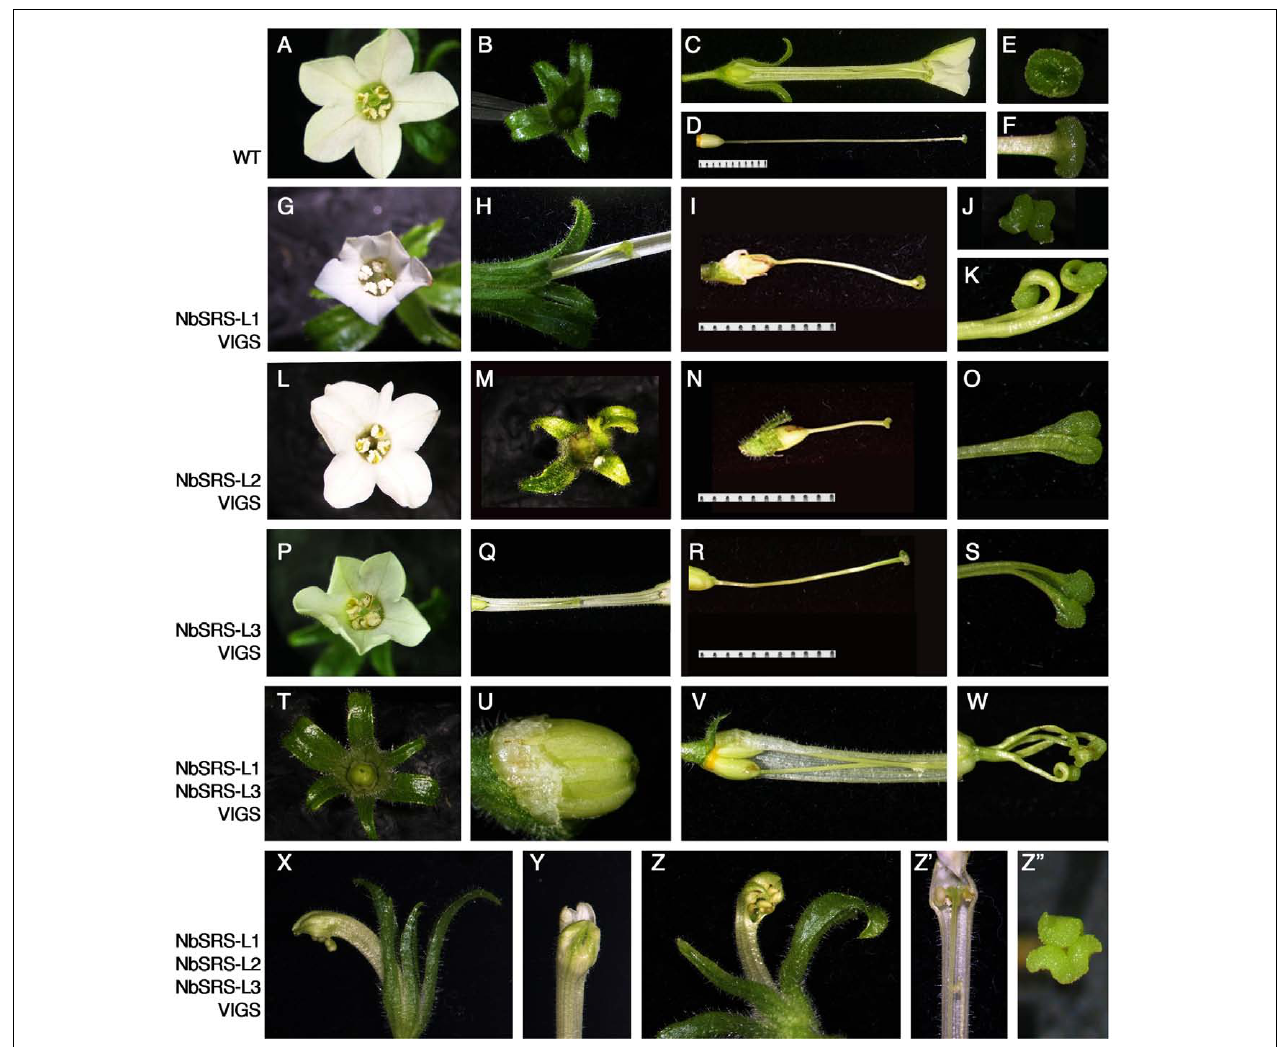
FIGURE 5 | Phenotypes of N. benthamiana plants inoculated with different pTRV2-NbSRS-L constructs. (A–F) Wild type N. benthamiana flower at anthesis. (A) Top view. Five expanded white petals and the central stigma surrounded by five stamens are clearly seen. (B) Top view of the dissected calix, formed by five green narrow sepals. (C) Lateral view of the flower, where some petals al sepals have been removed to show the ovary and the long style, that ends in a stigma leveled with the anthers. (D) Lateral view of the gynoecium. (E,F) Top and lateral view of the stigma. (G) NbSRS-L1-VIGS flower. The petals are reduced in size and the stigma is not visible at the center. (H) Lateral view of the basal part of the flowers, where some petals have been removed, to expose the short style. (I) NbSRS-L1-VIGS gynoecium. (J,K) Two examples of the defects found in the stigmas of NbSRS-L1-VIGS pistils. (L) NbSRS-L2-VIGS flower. The corolla is not symmetrical because one petal is severely underdeveloped. The stigma is not visible. (M) Top view of the dissected calix of a NBSRS-L2-VIGS flower. One of the sepals is reduced in size and deformed. (N) NbSRS-L2-VIGS gynoecium. (O) Close-up of the stigma shown in (N) , where the abnormal shape is visible. (P) Top view of a NbSRS-L3-VIGS flower. Note the unexpanded greenish corolla. (Q) Lateral view of a NbSRS-L3-VIGS flower where some petals have been removed to expose the short style. (R) Lateral view of a NbSRS-L3-VIGS gynoecium. (S) Example of defects observed in NbSRS-L3-VIGS styles. (T–W) Indeterminate phenotypes of flowers treated with TRV2-NbSRS-L1 and TRV2-NbSRS-L3 constructs simultaneously. (T) 6-sepal calix. (U) 4-carpel ovary. (V) Bi-pistillate flower. (W) Four style-like protrusions in a 4-carpel pistil. (X–Z”) Flowers inoculated simultaneously with the three TRV2-NbSRS-L constructs. (X–Z) Examples of mature flowers with severely unexpanded corollas. (Z’) Lateral view of a flower where a defective anther is visible. (Z”) Split and supernumerary